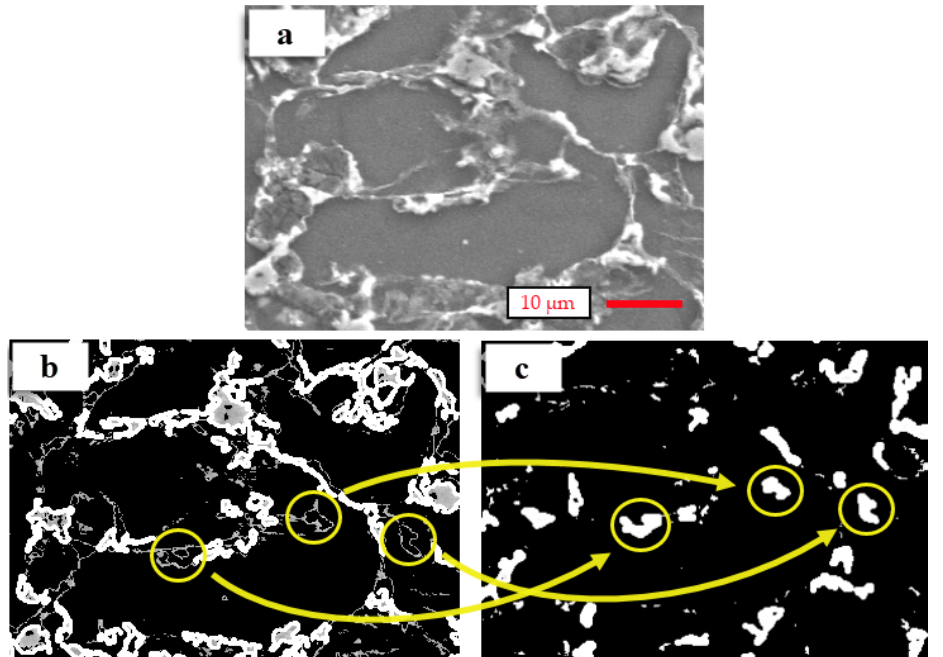
Figure 5. Comparison of the regions of grain boundaries on ( a ) the actual SEM image, ( b ) Mg 17 Al 12 phases in the processed image, and ( c ) Mg 2 Sn phases in the processed image.